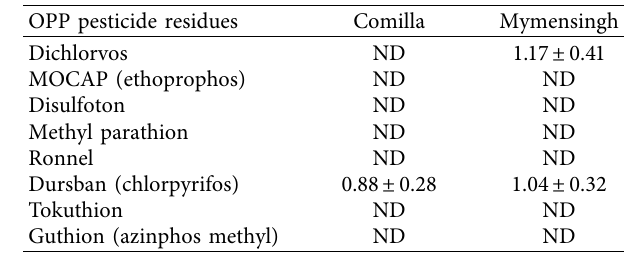
Figure 3: Chromatogram showing peaks of CB pesticide standards. The corresponding peaks of each residue are presented in the following order: 1: aldicarb sulfoxide; 2: aldicarb sulfone; 3: oxamyl; 4: methomyl; 5: 3-hydroxycarbofuran; 6: aldicarb; 7: propoxur; 8: carbofuran; 9: sevin (carbaryl); 10: Table 3: Mean concentration ( μ g/L) ± SD of detected OP residues Table 5: Mean concentration ( μ g/kg) ± SD of detected OP residues in water samples. in Pangasius pangasius fish muscle samples.